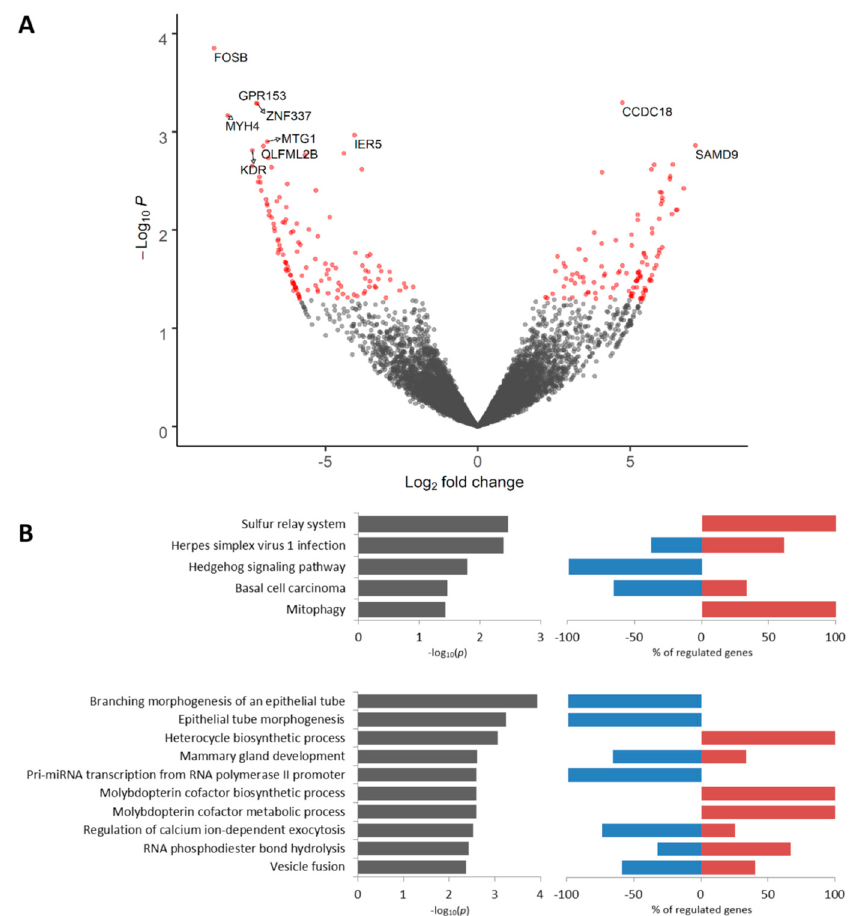
Figure 4. Differential expression analysis of Mieap-positive tumor cells. Volcano plot of TOP 10 up- and downregulated genes ( A ). TOP 10 KEGG signaling pathways and GO biological processes ( B ). Up- and downregulated genes with an unadjusted p -value < 0.05 were used for functional enrichment analysis. The left panel shows –log10p of the perturbation determined from a gene set test, whereas the right panel demonstrates a percentage of genes from corresponding KEGG and GO nodes that are down- and upregulated.